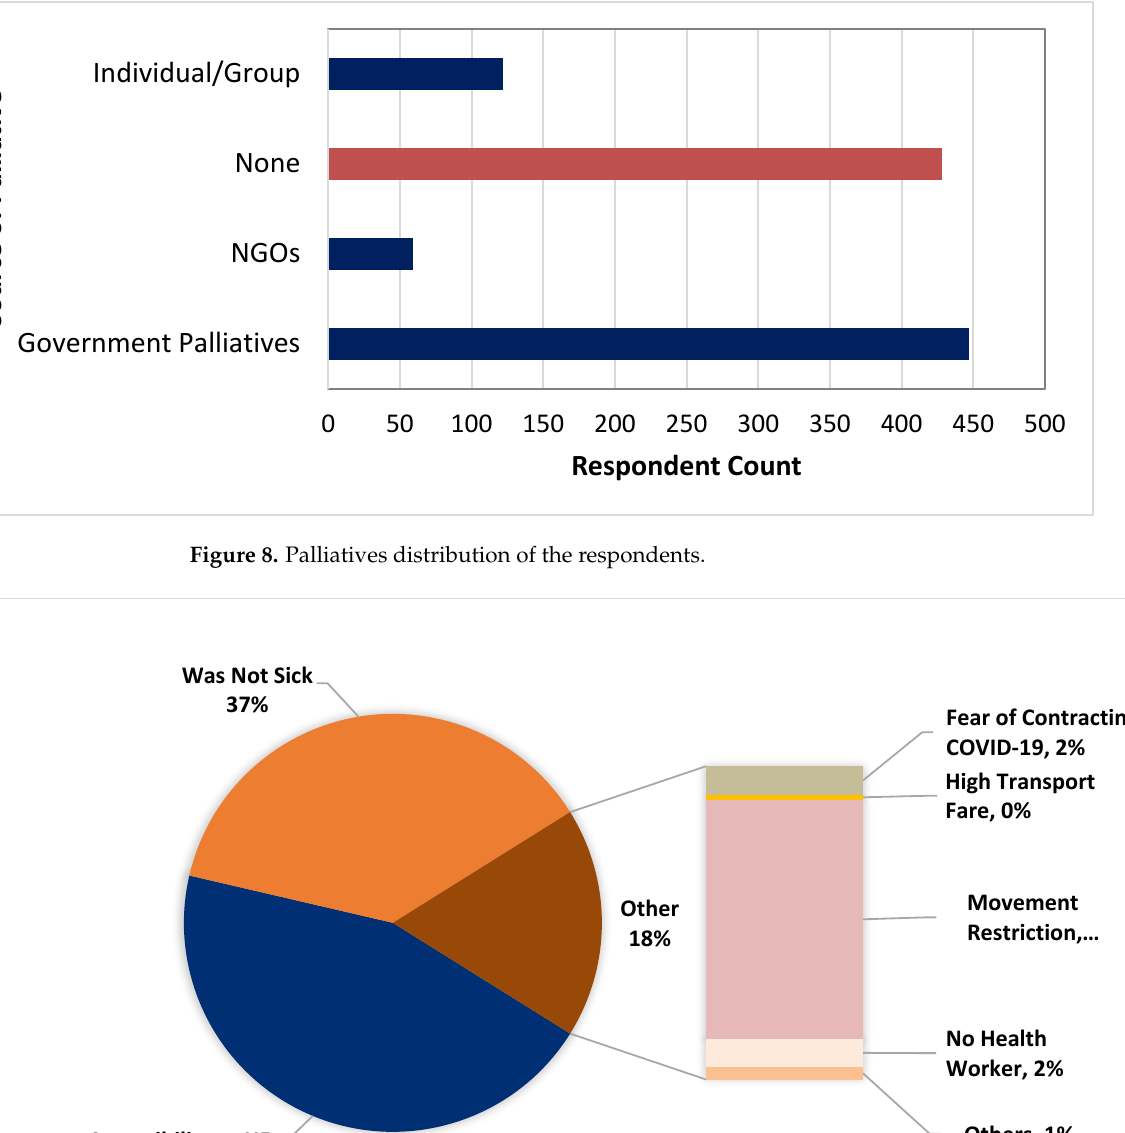
Figure 7. Distribution of the protective behaviors of the respondents.